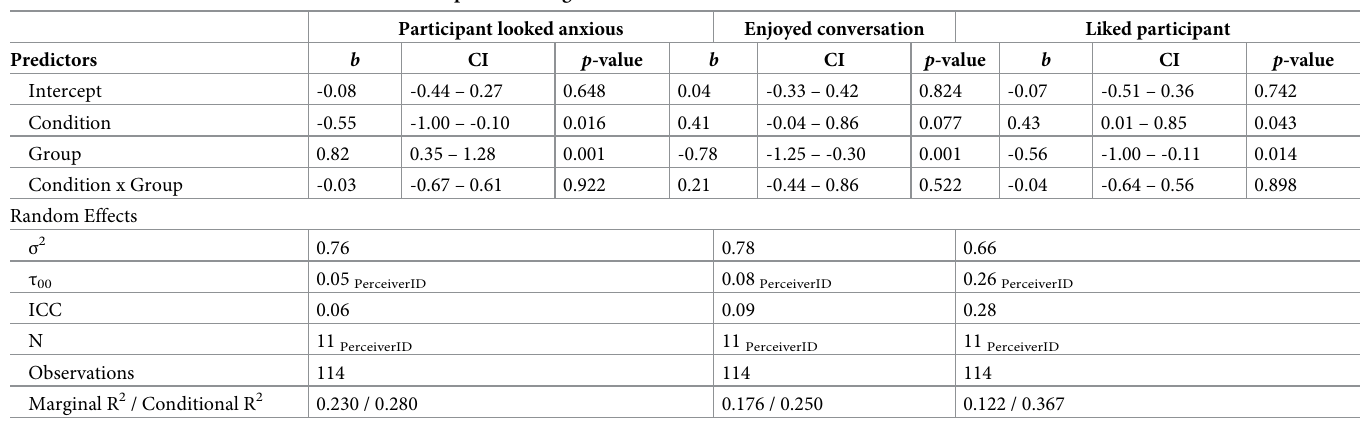
Table 5. Linear mixed model results for conversation partner ratings.